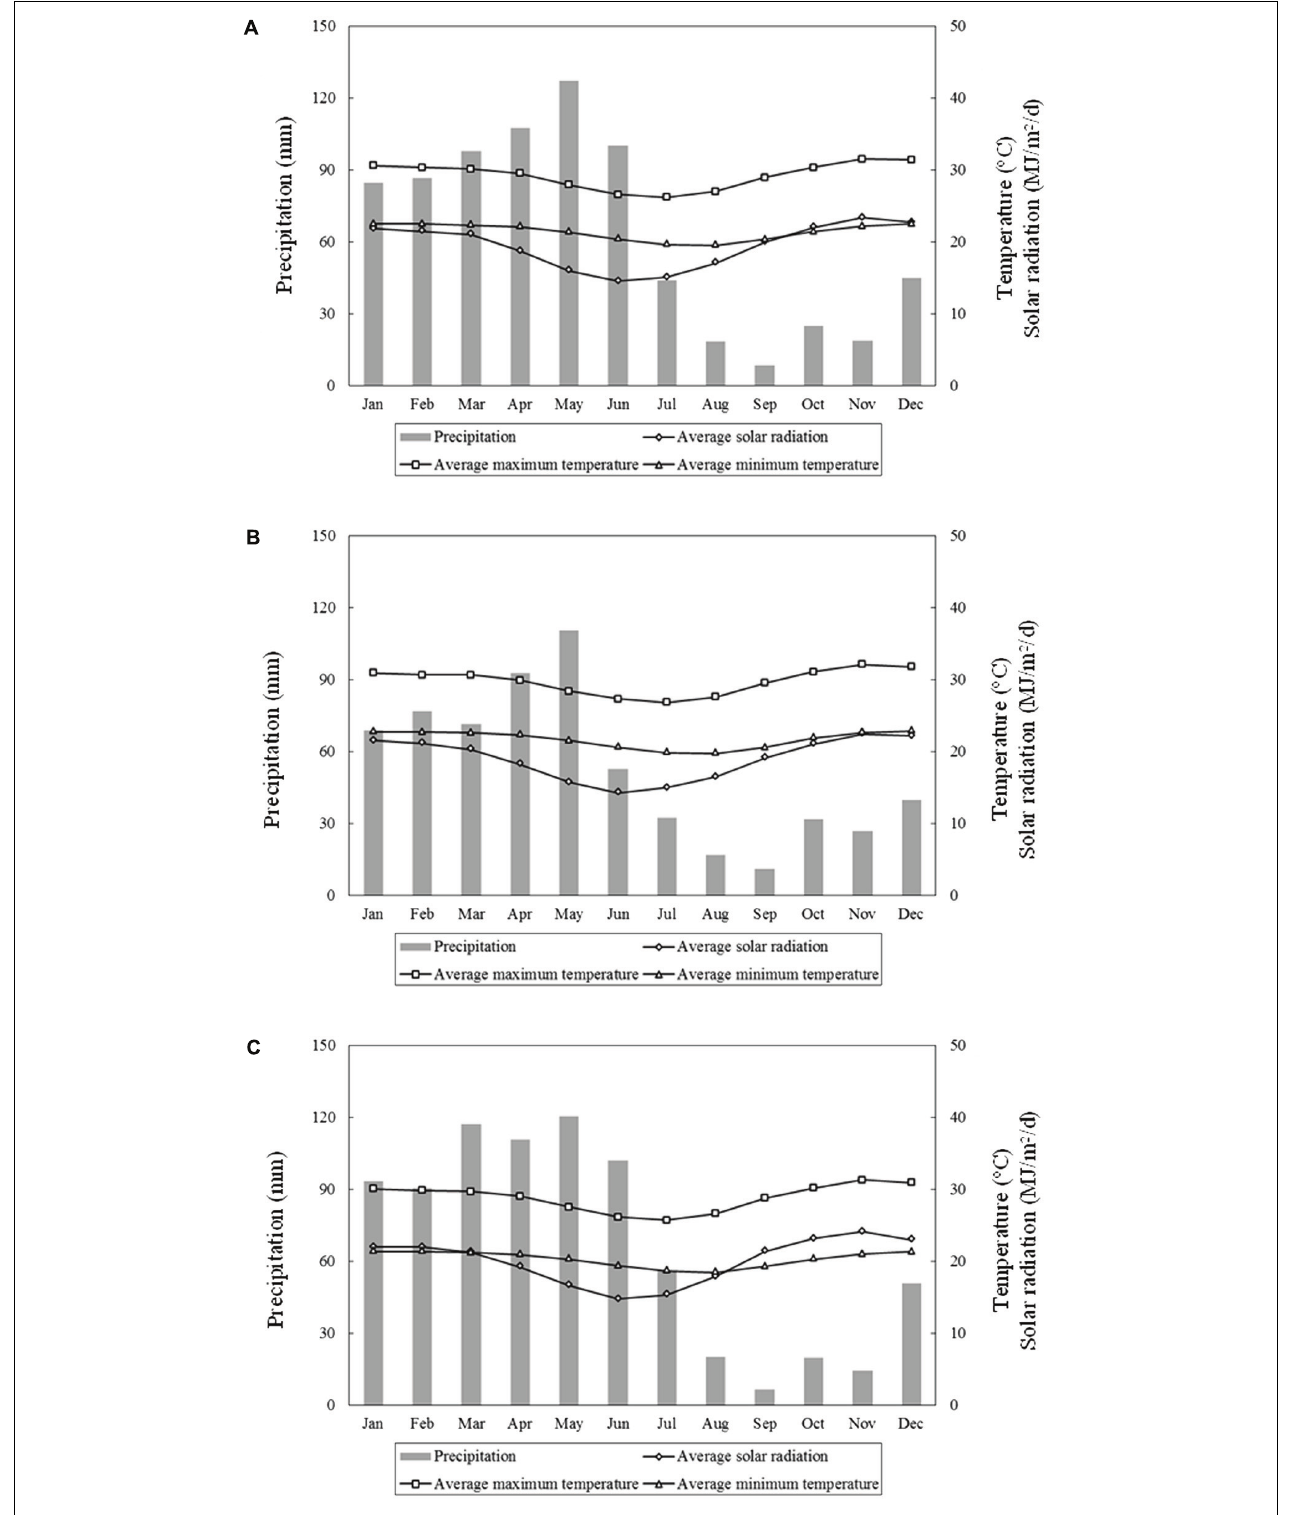
FIGURE 1 | Average monthly precipitation, average maximum and minimum temperature, and average solar radiation for Bom Conselho (A) , Nossa Senhora da Gloria (B) , and Sao Bento do Una (C) for 1997–2011.